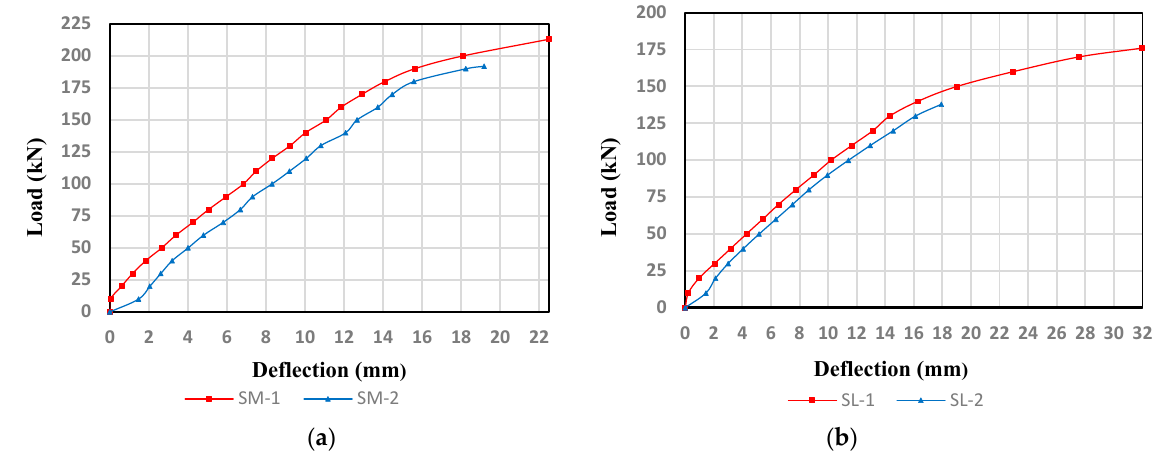
Figure 13. Load–deflection curve for: ( a ) SM-1 and SM-2, ( b ) SL-1 and SL-2.